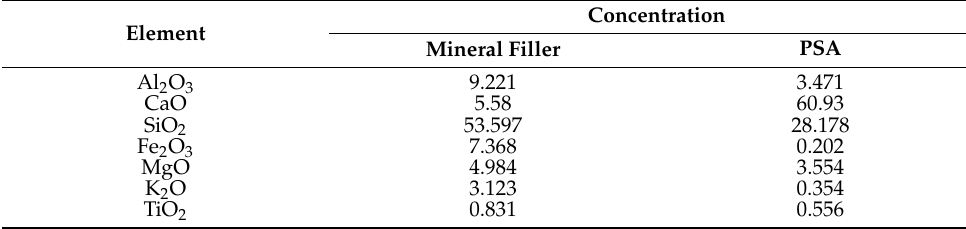
Table 2. Chemical composition of